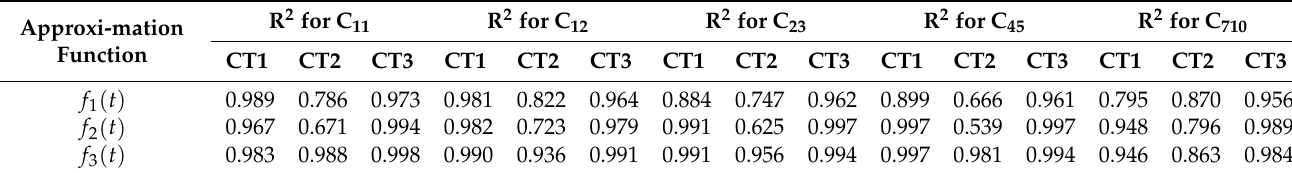
Table 5. R 2 parameter of function approximation for CT1, CT2, and